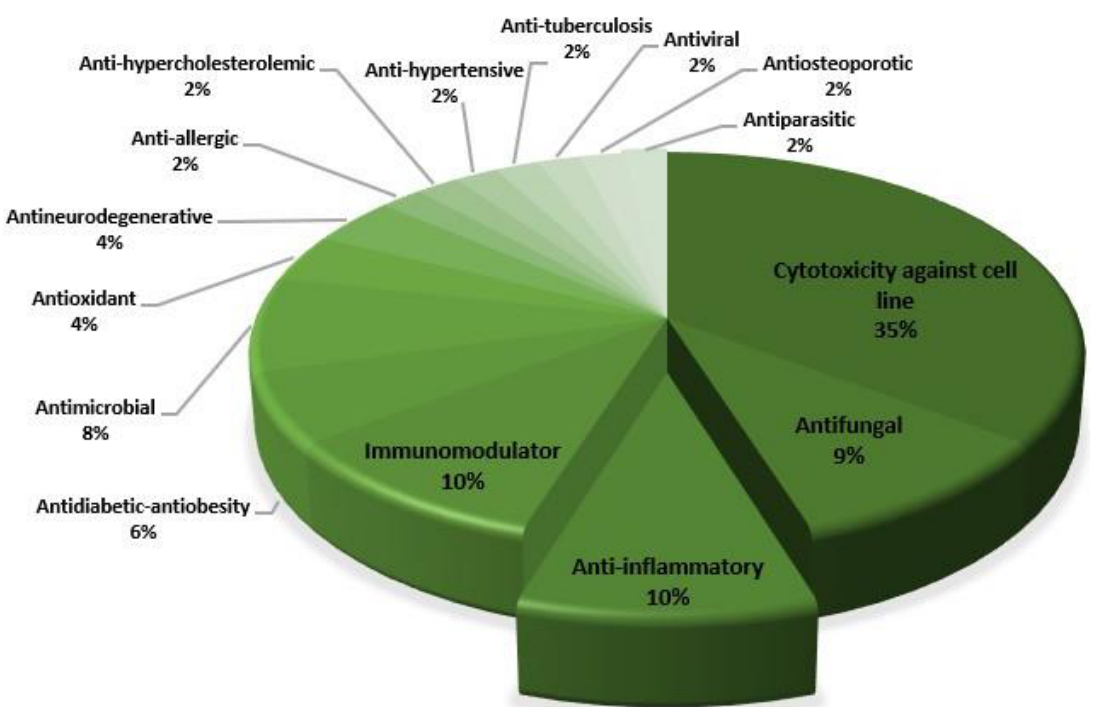
Figure 13. Distribution of the pharmacological activities reported in Callyspongia spp .